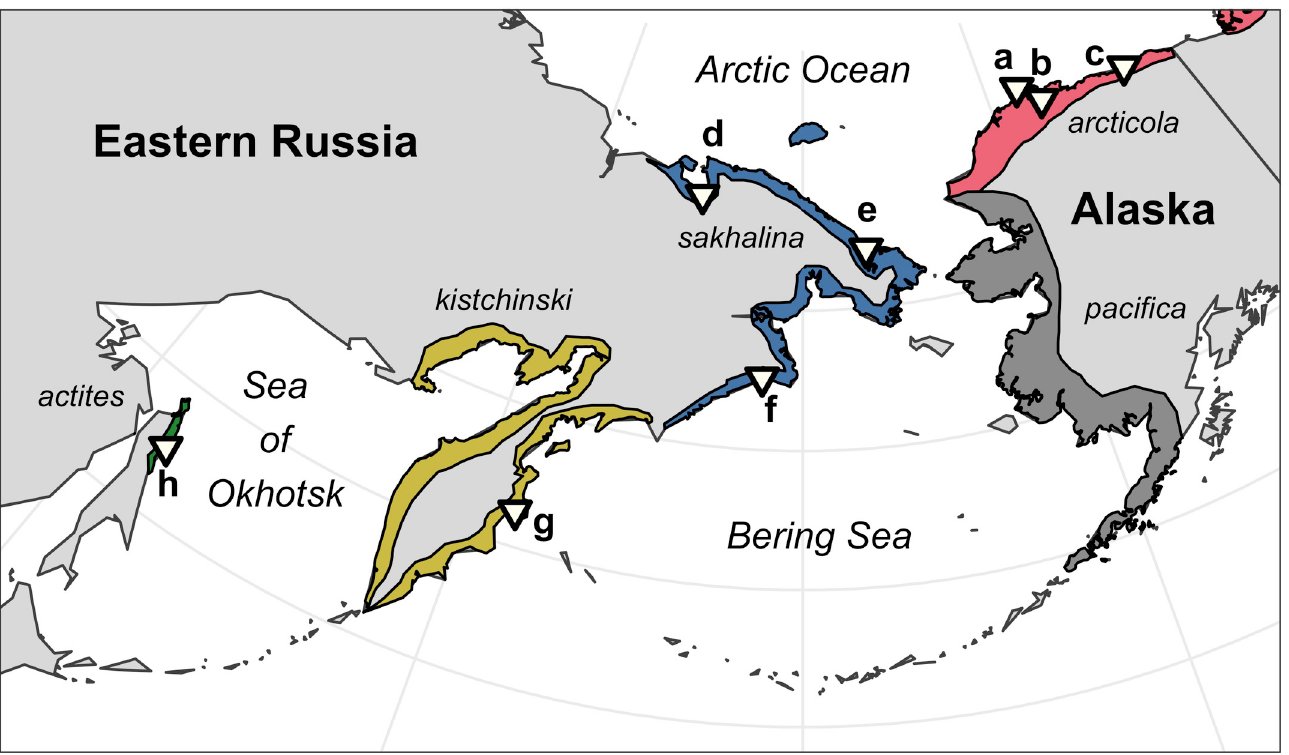
Fig 1. Breeding ranges of the 5 Dunlin subspecies that occur in the North Pacific, and the location of each field site (a–h) where light-level geolocators were deployed. See Table 1 for site info. The pacifica subspecies does not migrate and winter along the East Asian-Australasian Flyway and is not discussed in this paper.